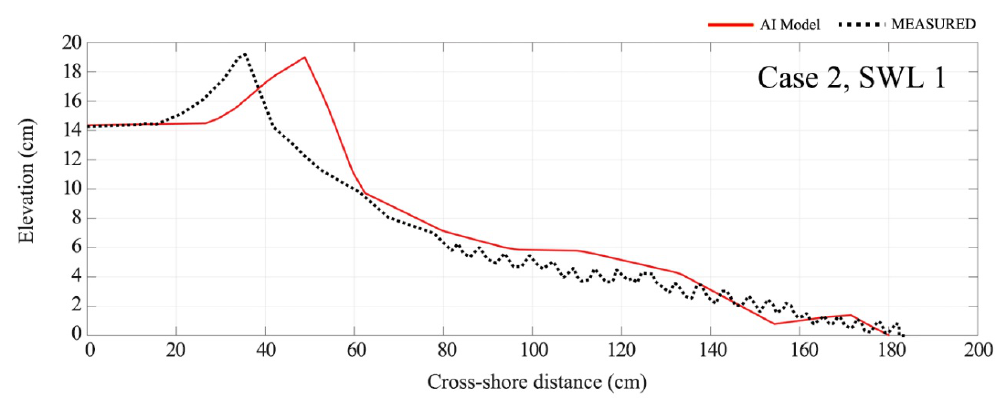
Figure 16. Case 2 SWL 1 comparison of the ANN prediction and measured from the physical test.